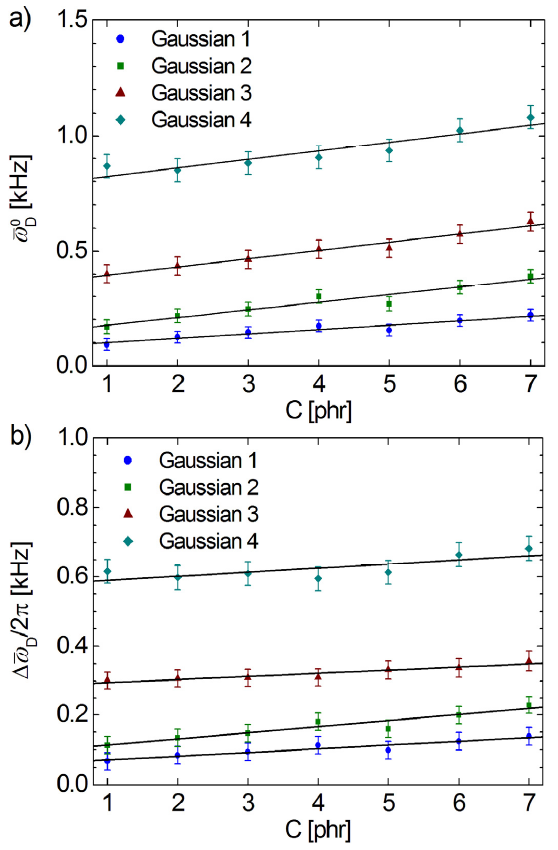
Figure 7. The dependence of ( a ) the mean value of the residual dipolar couplings and ( b ) line width for the Gaussian distribution functions of the cross-link density C (sulfur accelerator content—phr). In all cases, the lines represent the best fit of the data.